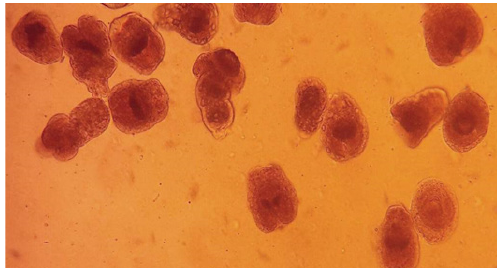
Fig. 10. Effect of albendazole 1000 mg / ml in the viability of protoscolices on day 6 (hour 120). (Power zoom